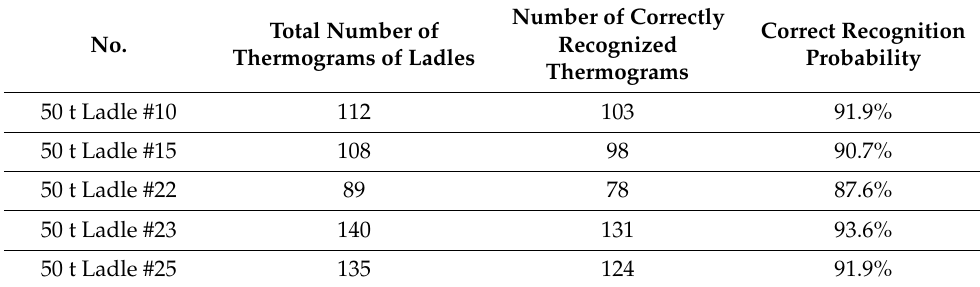
Number of Correctly Correct Recognition Recognized Thermograms